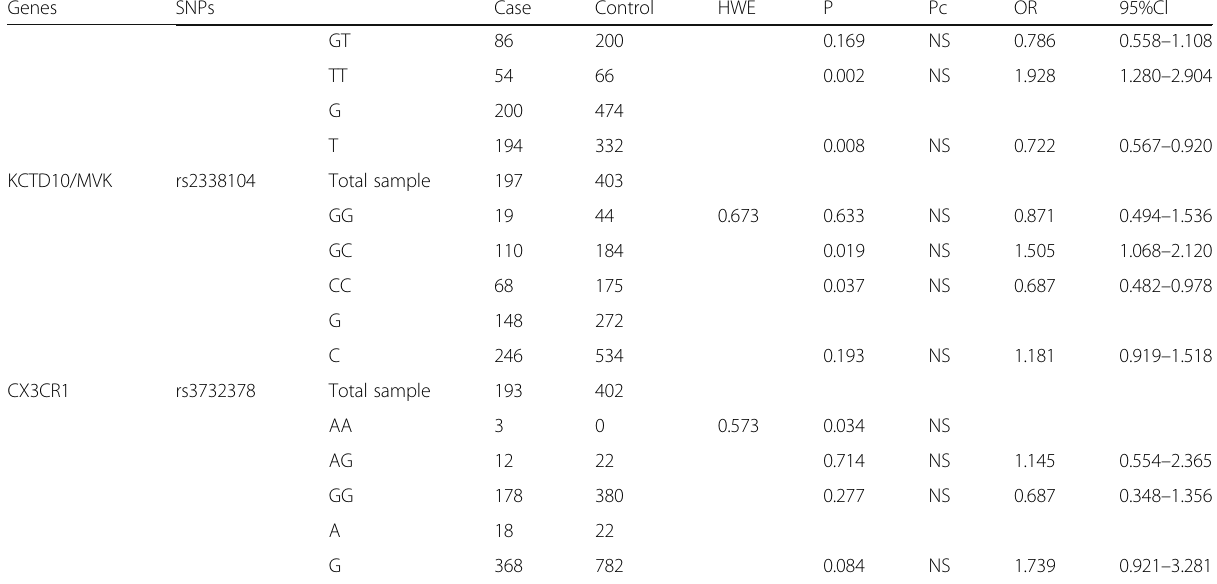
Table 2 Genotype and allele frequencies of ten genes ’ polymorphism in AMD and healthy controls (Continued) Genes SNPs